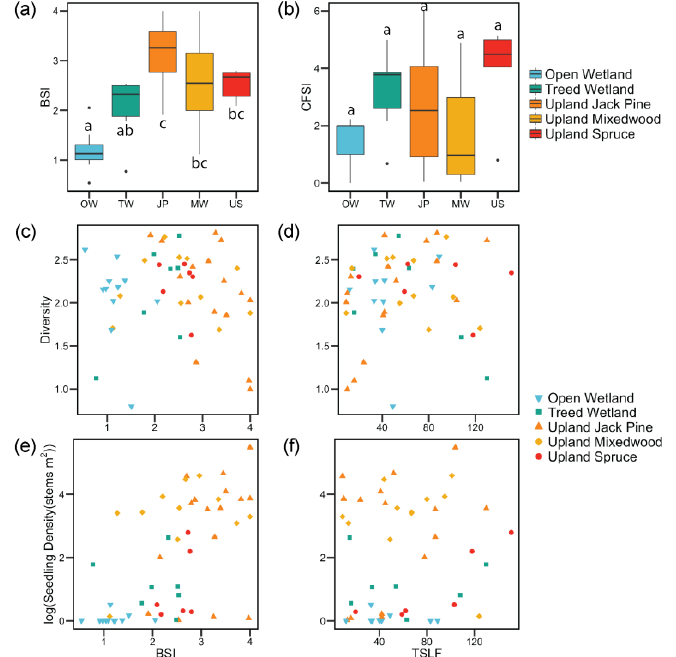
Figure A2. Descriptive plots of observed burn severity, fire history, and topoedaphic vegetation classes in relation to Shannon diversity index and seedling density within sampled plots. Patterns of burn severity within topoedaphic vegetation classes of open wetland (OW), treed wetland (TW), upland mixedwood (MW), upland jack pine (JP), and upland black or white spruce (US) are presented in ( a ) boxplots of surface burn severity index (BSI), and ( b ) boxplots of canopy fire severity index (CFSI). Letters associated with boxplots indicate significant differences ( α = 0.05) in a Tukey test of least-squares means. Shannon index is shown as a function of BSI ( c ) and time since last fire (TSLF); ( d ), and the natural logarithm of stem density of seedlings is also shown as a function of BSI ( e ) and TSLF ( f ).